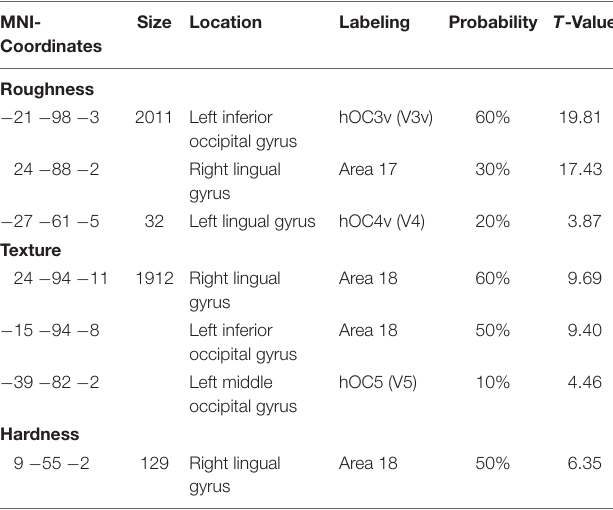
TABLE 1 | Overview of the significant clusters ( k > 5) identified with the searchlight approach.